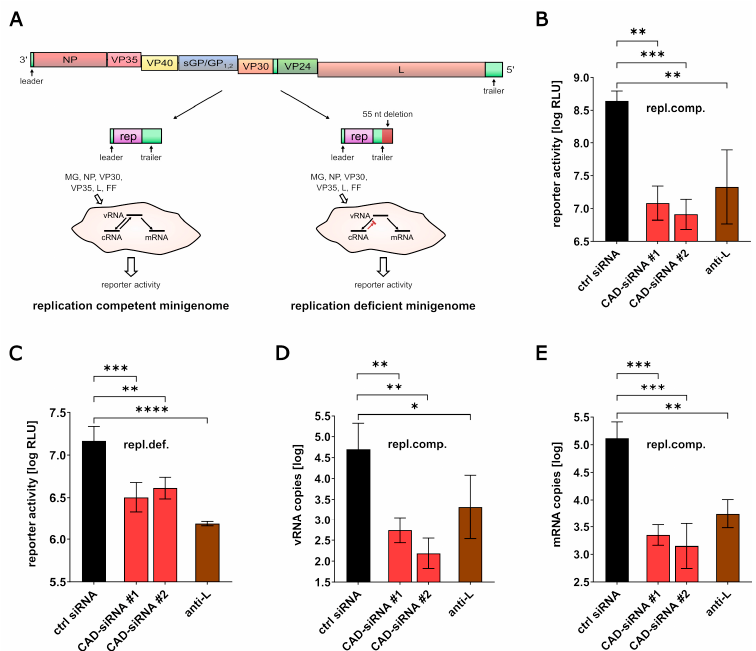
Figure 2. Influence of CAD knockdown on the Ebola virus life cycle. ( A ) Replication-competent and -deficient minigenome systems. The full-length genome structure of EBOV, as well